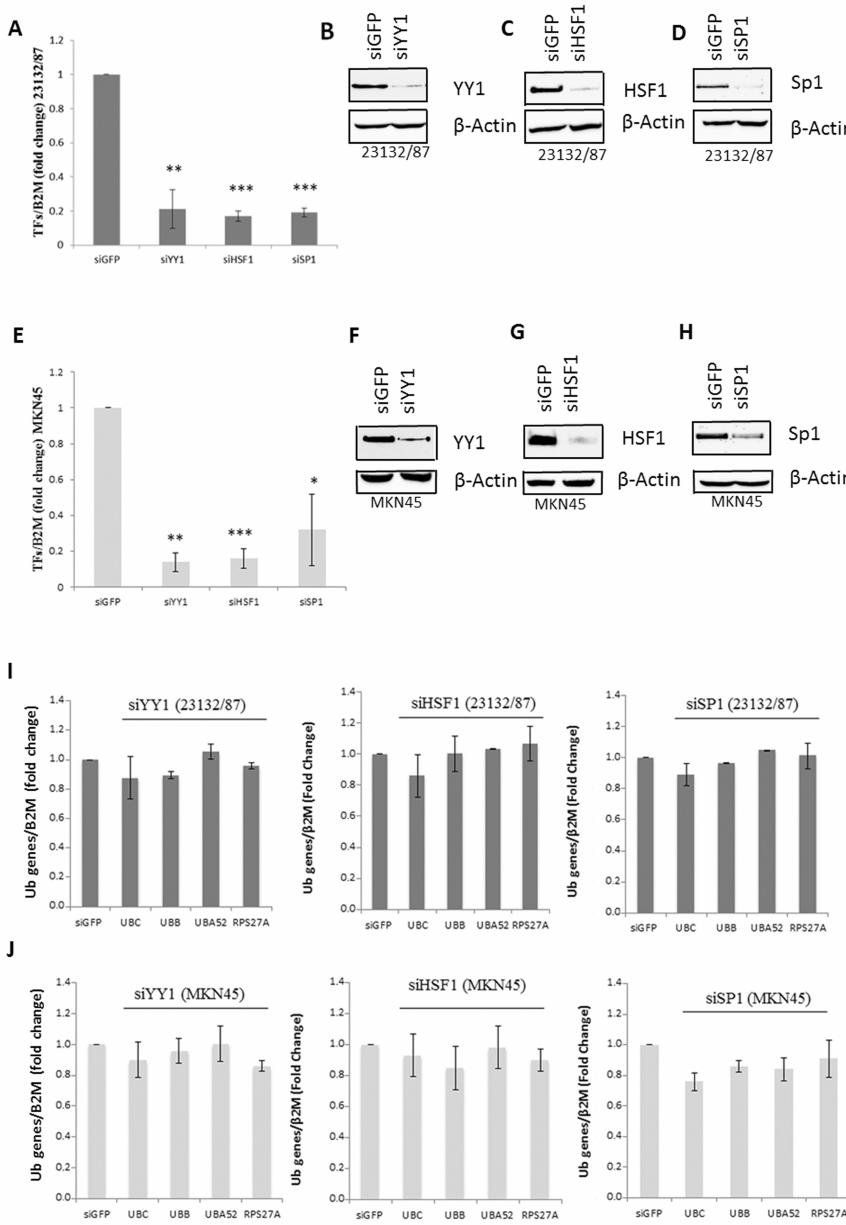
Figure 3. siRNA-mediated knockdown of YY1, HSF1 and SP1 transcription factors and Ub gene expression levels after RNA interference treatments in the 23132 / 87 and MKN45 cell lines. 23132 / 87 ( A ) and MKN45 ( E ) cells were transiently transfected with YY1 , HSF1 , SP1 and control GFP siRNAs. At 48 h after transfection, the mRNA levels of the target genes were measured by real-time quantitative PCR, normalized to B2M mRNA and depicted as fold change compared with si GFP transfected cells. Data are means ± SD ( n = 3); * p < 0.05, ** p < 0.01, *** p < 0.001. Representative western immunoblots of total proteins from 23132 / 87 ( B – D ) and MKN45 ( F – H ) cells transfected with either control (si GFP ) or YY1 , HSF1 or SP1 siRNAs, at 48 h post-transfection ( n = 3). A quantity of 15 µ g of total cellular proteins was loaded and probed with antibodies specific for YY1 ( B , F ), HSF1 ( C , G ) or SP1 ( D , H ); blots were reprobed with anti- β -Actin, used as a loading control. 23132 / 87 ( I ) and MKN45 ( J ) cells were transiently transfected with YY1 , HSF1 , SP1 and control GFP siRNAs. After 48 h, the mRNA levels of UBC , UBB , UBA52 and RPS27A genes were measured by real-time quantitative PCR, normalized to B2M mRNA and depicted as fold change compared with si GFP transfected cells, set as 1. Data are means ± SD ( n =